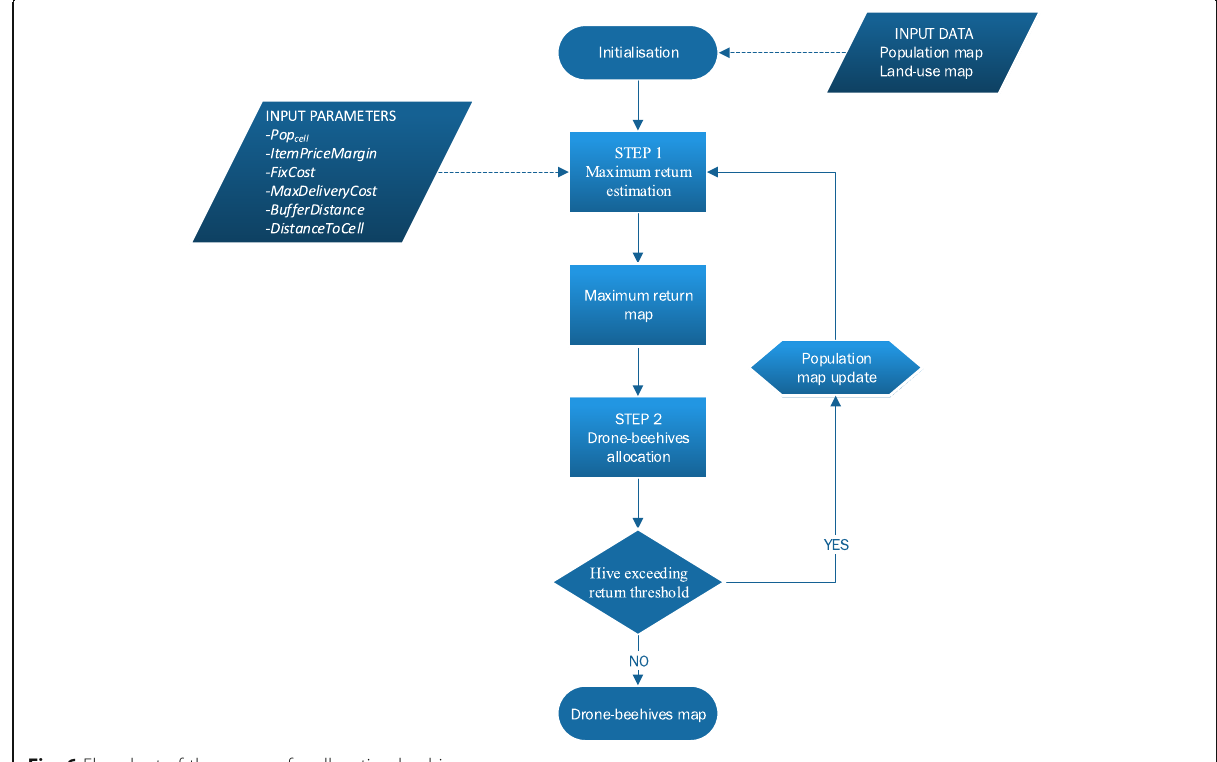
Fig. 6 Flowchart of the process for allocating